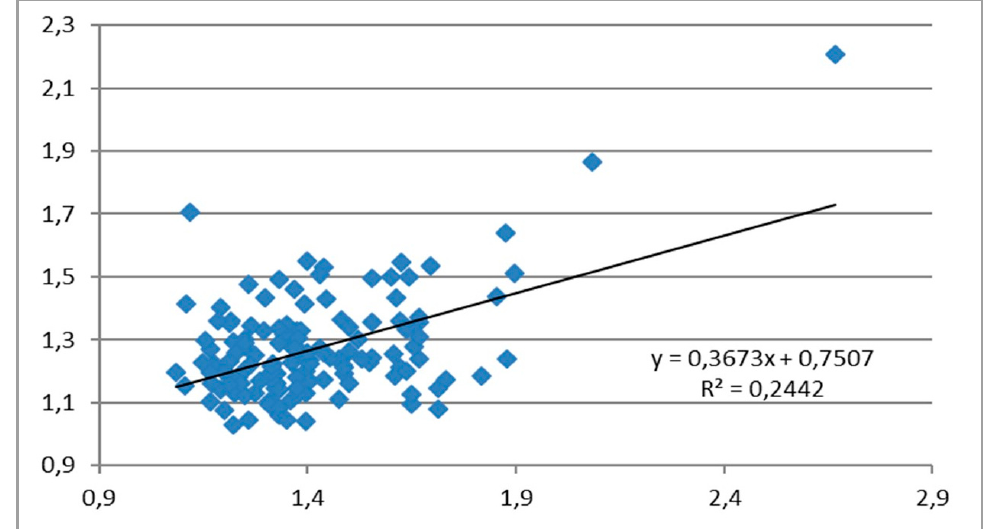
Figure 2. Correlation between the clinically measured hyomental distance ratio (HMDR clin ) and ultrasound-measured hyomental distance ratio (HMDR echo ) in patients without morbid obesity.